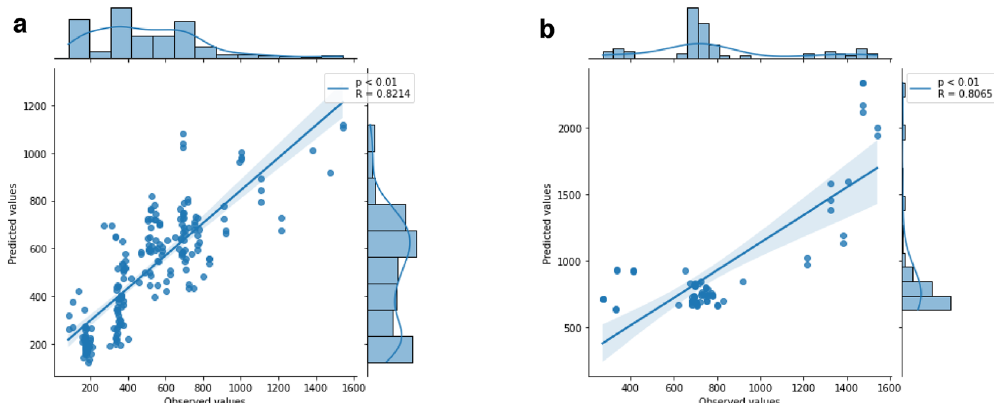
Figure 6. Pearson correlation between predicted and observed values. ( a ) Correlation based on the model with the lowest MSE in the Huh7 cell line. ( b ) Correlation based on the model with the highest MSE.